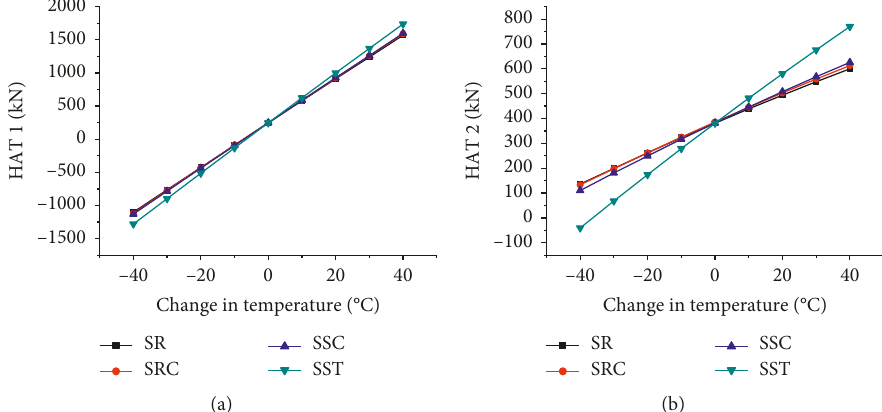
Figure 7: Relationship between the horizontal arch thrust and the temperature in the full-span load distribution. Change in (a) HAT1 and (b) HAT 2 with varying temperature.